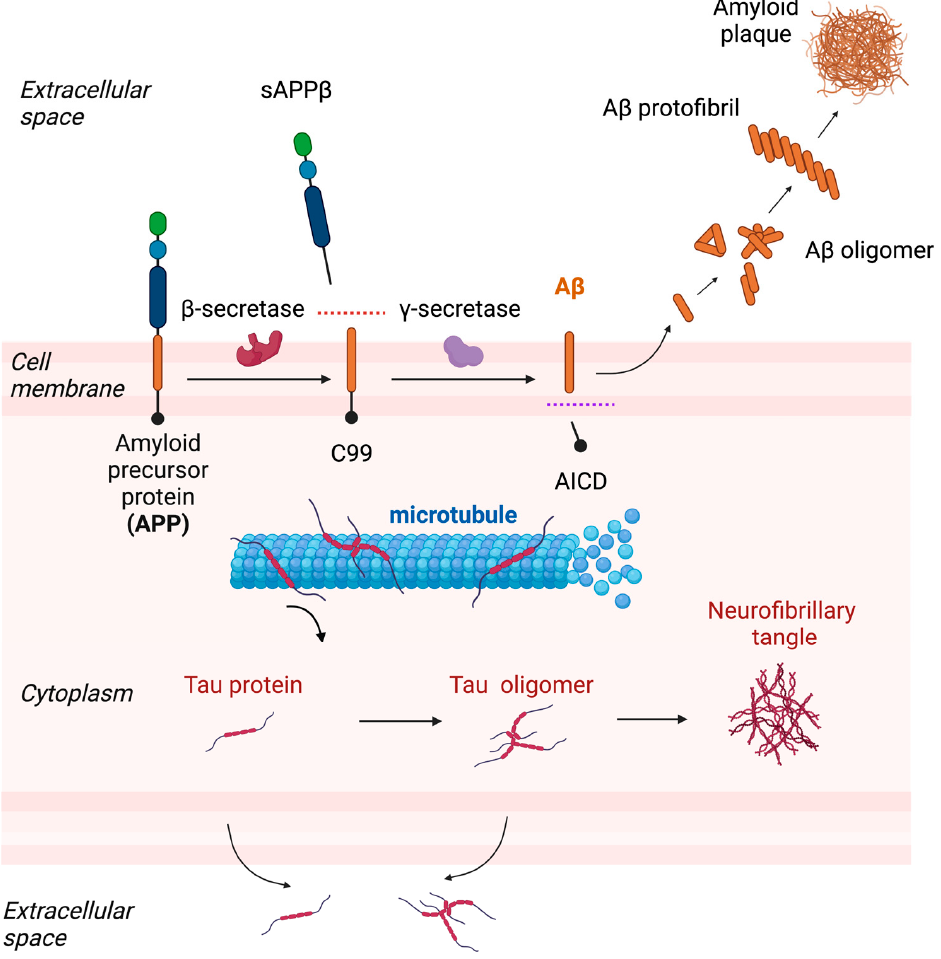
Figure 1. The aggregation process of A β and tau and their release. A β is generated from APP after sequential cleavages by β -secretase and γ -secretase and multimerizes into oligomer or protofibril and finally deposits as amyloid plaques. Tau is a microtubule binding protein but becomes detached from microtubules and forms oligomer and deposits as neurofibrillary tangles. Accumulating evidence has now suggested that tau is also released into the extracellular space and therefore a target of extracellular fluid clearance (adapted from “Cleavage of Amyloid Precursor Protein (APP)” and “Pathology of Alzheimer’s Disease” by Biorender.com (accessed on 28 March 2023).